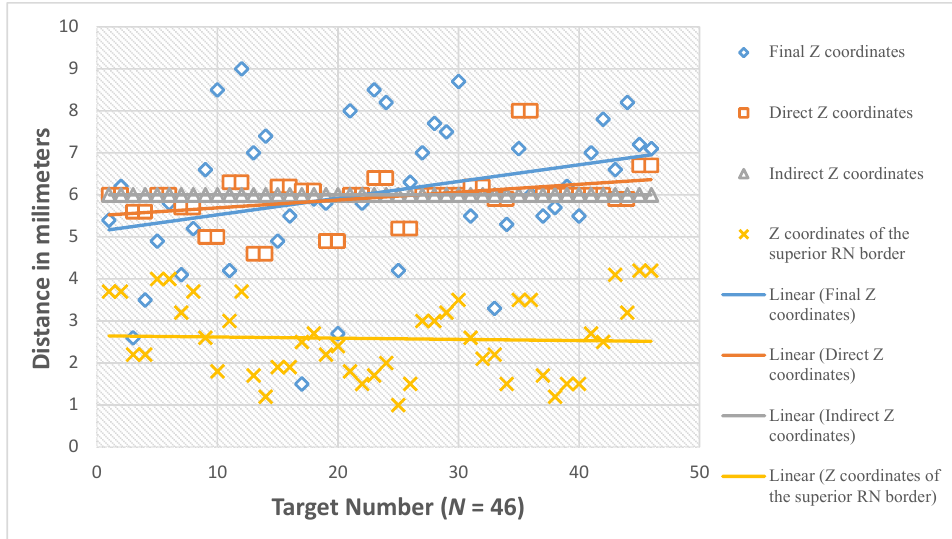
Figure 14. The Z coordinates in relation to the MCP.